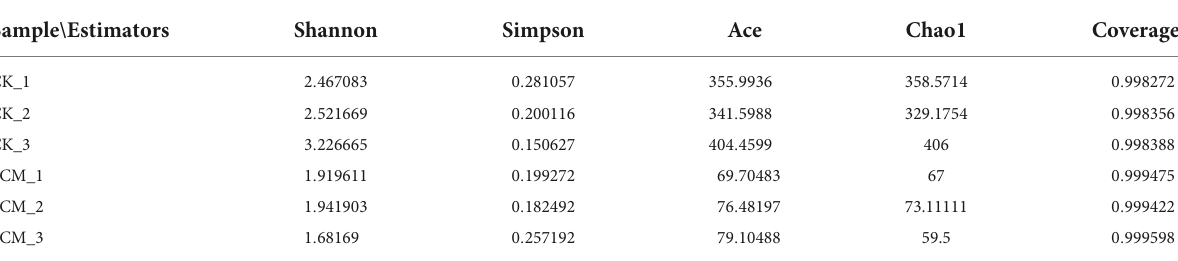
TABLE 3 Samples alpha diversity analysis